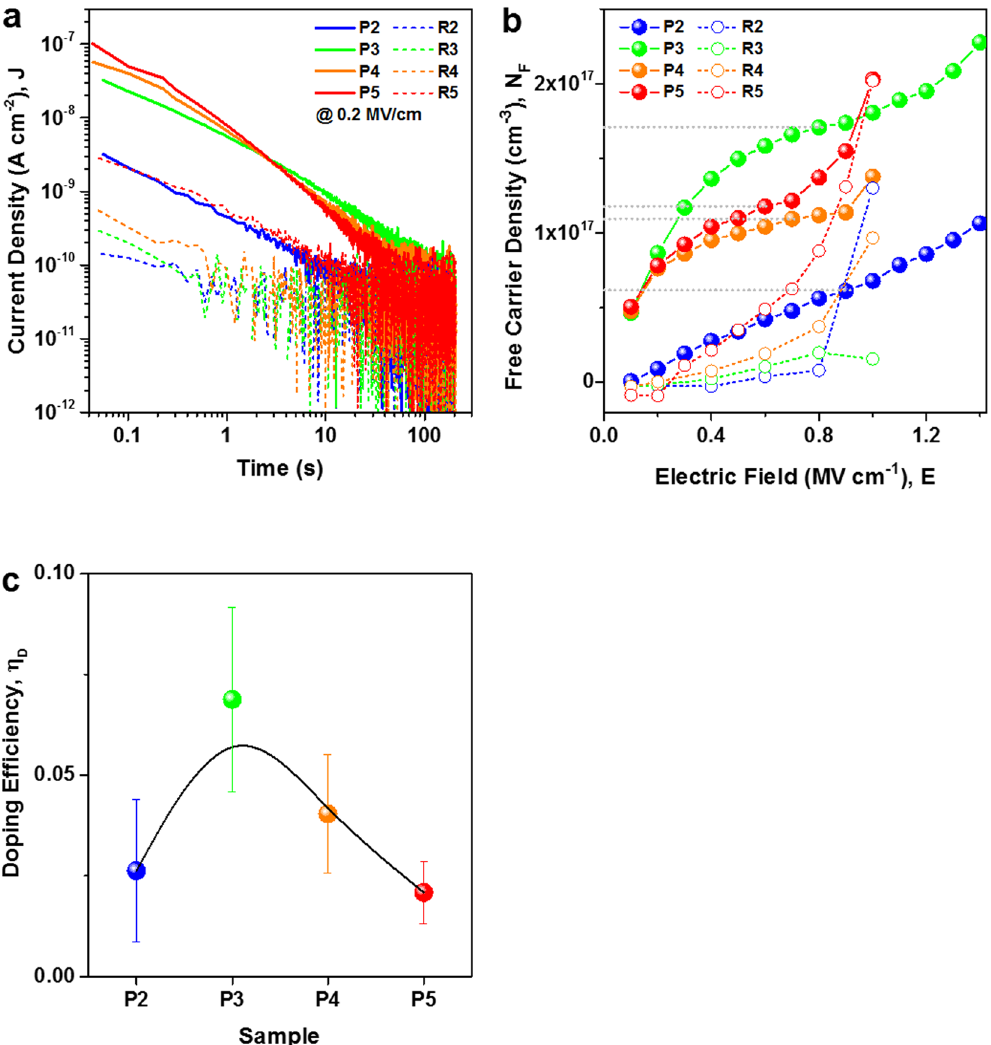
Figure 4. Free carrier density and doping efficiency. ( a ) J-t-measurement of all samples at an E-field of 0.2 MV/ cm. The transient currents scale within one order of magnitude with the increasing Si-content of the sample and are increased by up to two orders of magnitude by P-doping. ( b ) Density of charge carriers N F as function of electric field, measured at room temperature. Each data point represents a J-t measurement on a virgin contact, so that any influence from charging of a preceding measurement is avoided. The grey dotted lines indicate approximately the saturation point. For η D calculations, the background carrier density of the undoped reference samples at saturation is subtracted. ( c ) Doping efficiency η D as ratio of free carriers (at E-fields of ~0.1 to 0.6 MV/cm) and the number of P-atoms incorporated by Si NCs. The black solid line (spline) is just a guide to the